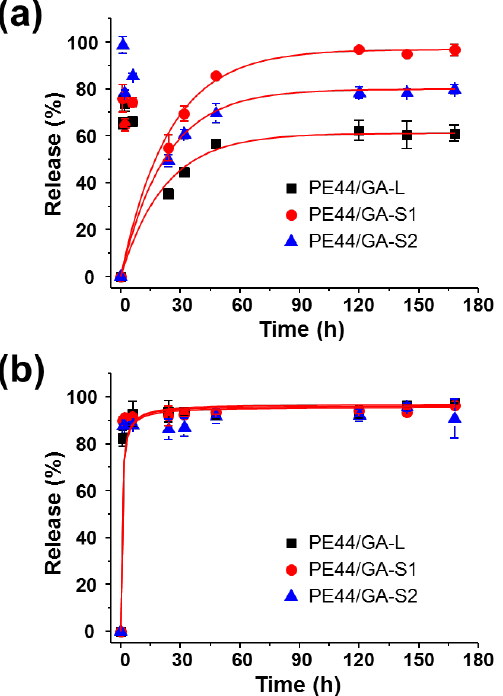
Figure 8. Accumulated release profiles of GA-S1, GA-S2 and GA-L peptides from loaded PE44 electrospun fibers in ( a ) PBS and ( b ) PBS-EtOH.